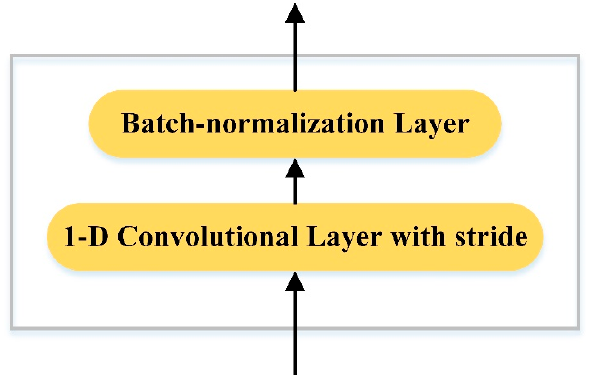
Figure 3. The structure of convolutional block.